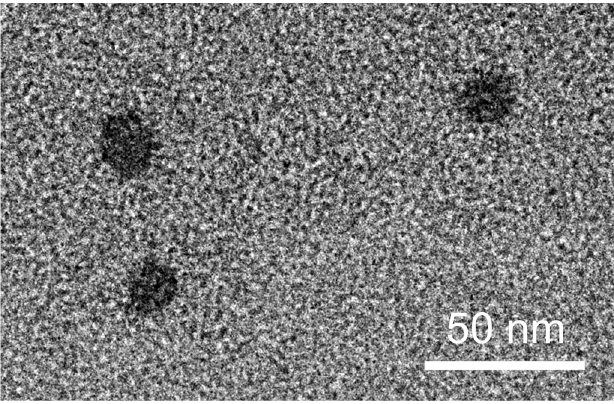
Figure 5. TEM image of SNEDDS-F4.